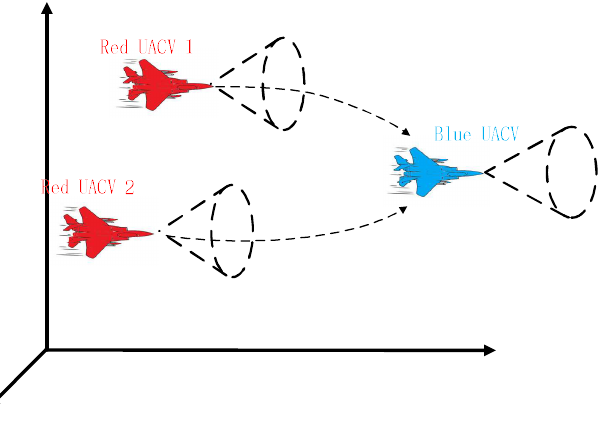
Figure 1. Schematic diagram of air combat.